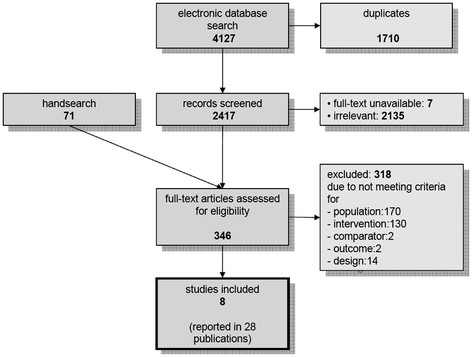
Study flow diagram.